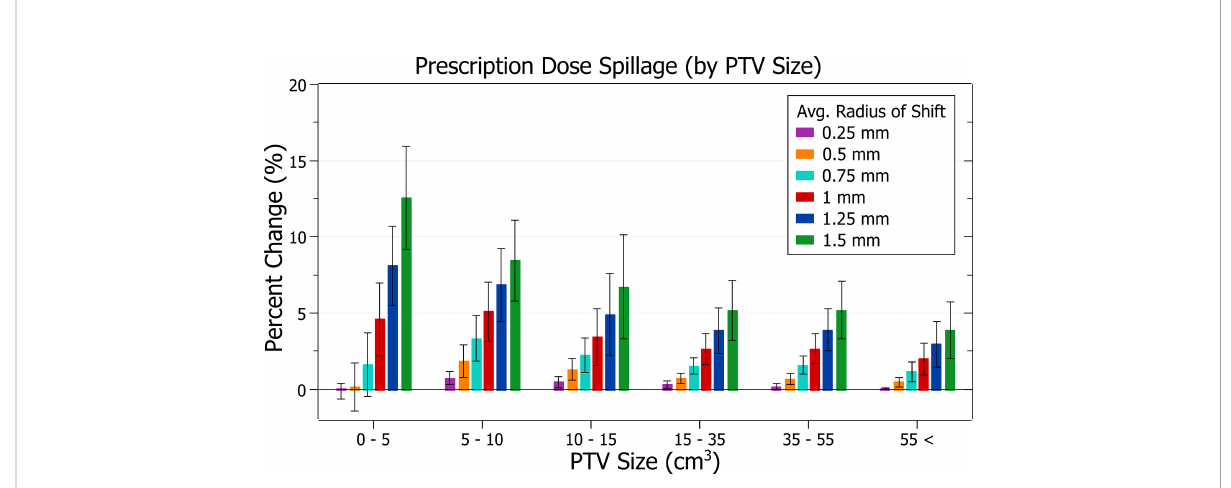
FIGURE 9 Average percentage change of prescription dose spillage for different radii of isocentre shift, categorised by PTV